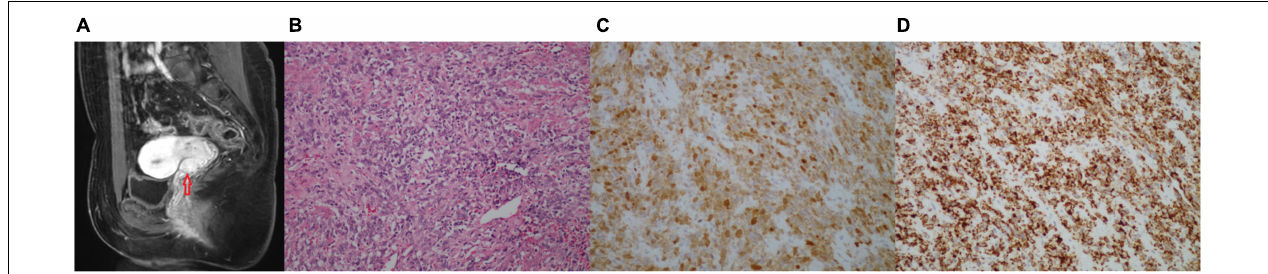
FIGURE 1 | (A–D) Images of the cervical tumor. (A) The pelvic MRI (sagittal T1-weighted images with contrast) showing a 1.8 × 1.5 × 1.3 cm abnormal signal in the anterior wall of the cervical-vaginal junction, which was considered a neoplastic lesion. (B) H&E-stained (200 × ) of the cervical tumor: the tumor tissue was composed of diffused spindle cells, arranged in crisscross bundles, sheets, or zigzag, and many blood vessels were seen and had low to moderate grade nuclear atypia. (C) Immunohistochemical (IHC) of S-100 (200 × ) was positive. (D) IHC of Pan-TRK (200 × ) was strongly positive.